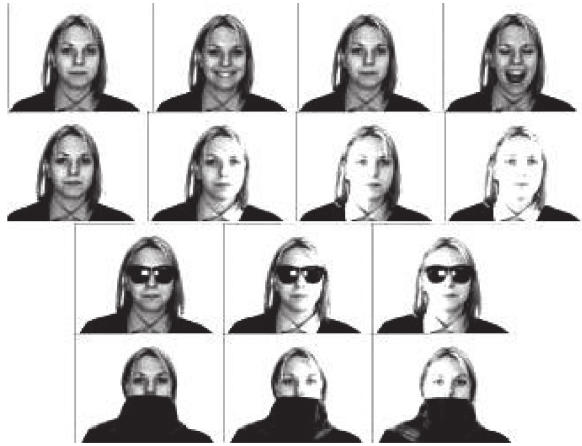
Figure 6: A part of face images.